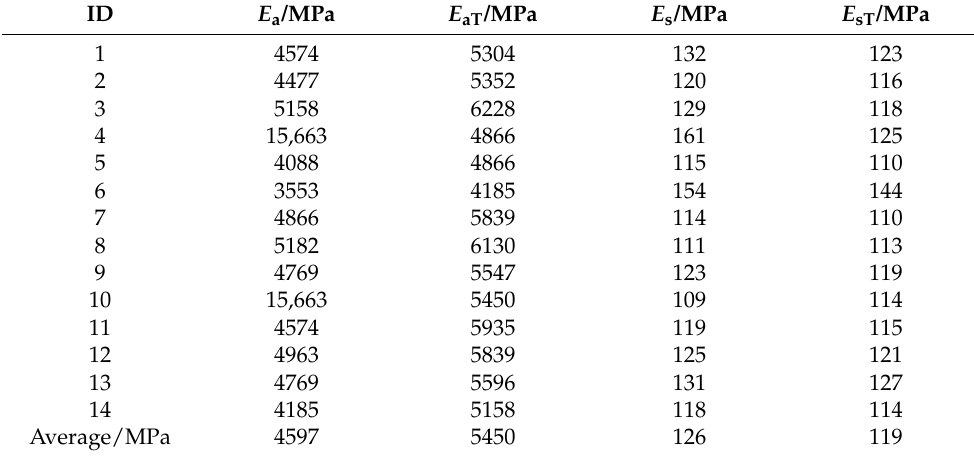
Table 7. The backcalculated layer